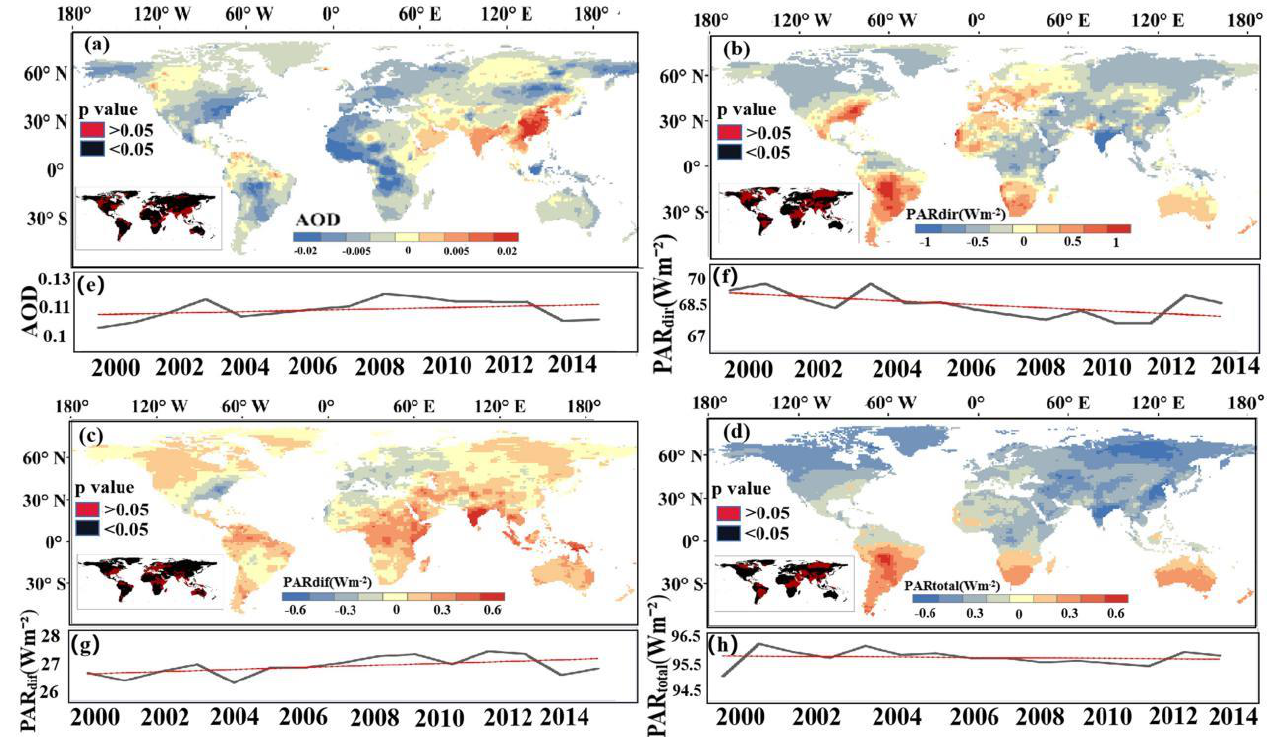
Figure 3. The spatial distribution of the trends in mean of ( a ) AOD, ( b ) PAR dir (W m −2 ), ( c ) PAR dif (W m −2 ), and ( d ) PAR total (W m −2 ) from 2000 to 2014. The map insets in ( a – d ) show the significance level of the trends of AOD, PAR dif, PAR dir , and PAR total , respectively, with the red area indicating significant trends ( p -value < 0.05) and the black area indicating insignificant trends. The temporal variation of annual AOD, PAR dir , PAR dif and PAR total that were spatially averaged over the globe are illustrated in ( e – h ), respectively; the red lines are the fitting lines.